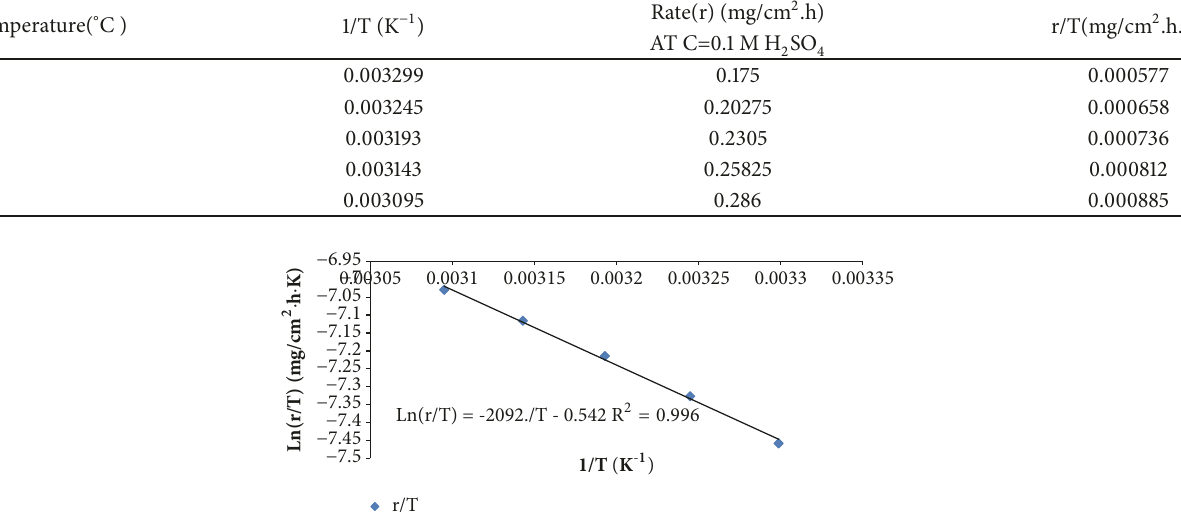
Multiply (10) by (r) and the result